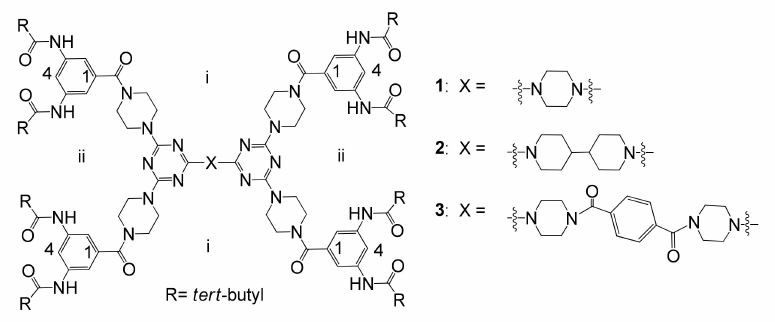
Figure 1. The molecular structures of dendrimers 1–3